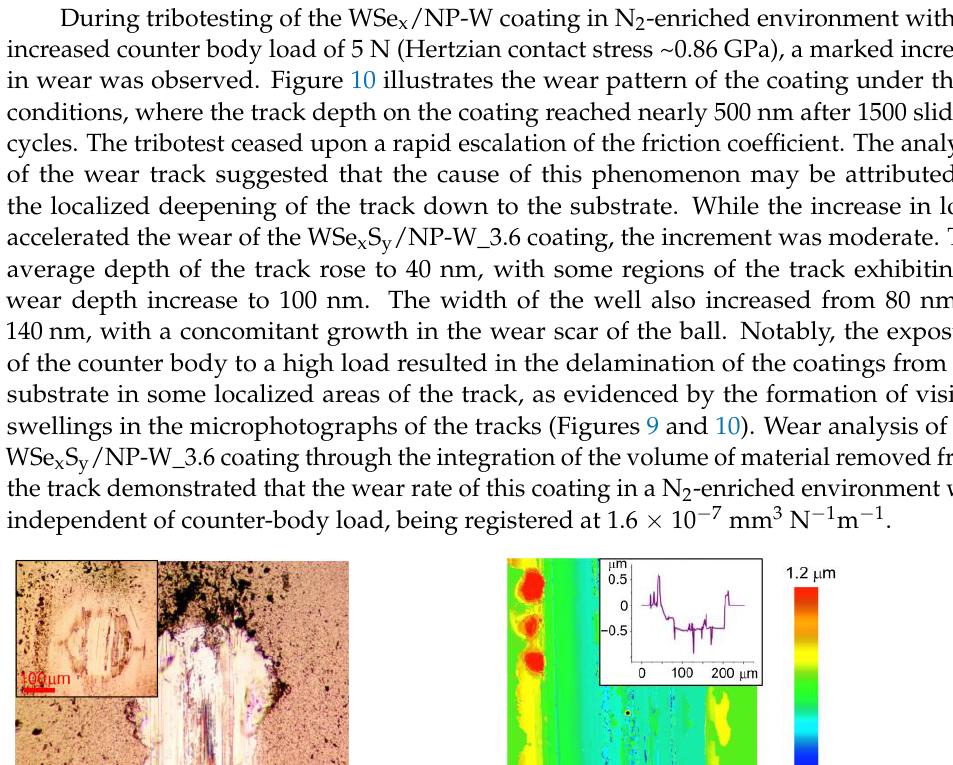
Figure 9. Wear of the ( a , b ) WSe x /NP-W and ( c , d ) WSe x S y /NP-W_3.6 coatings after tribotest in N 2 - enriched environment at a load of 1 N: inserts in ( a , c ) show the wear scars of counter bodies (balls), and the depth profile of the wear tracks are shown in the inserts in ( b , d ).